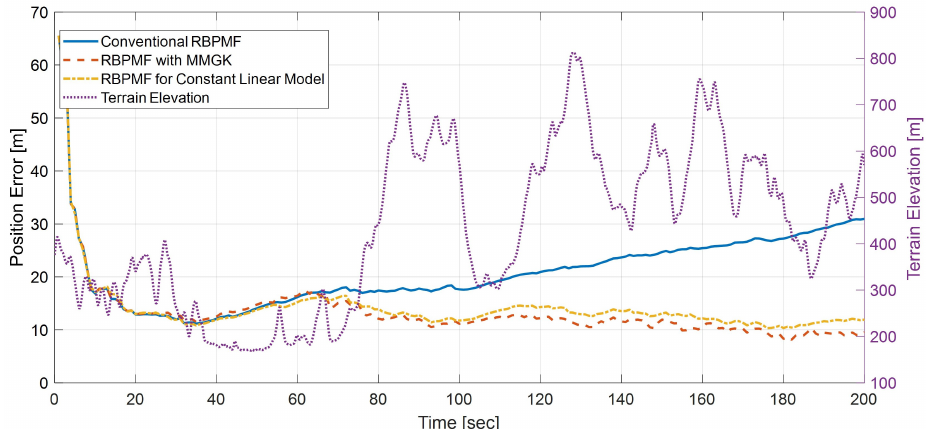
Figure 12. Comparison of the position error RMS of the conventional RBPMF (Algorithm 3), RBPMF with MMGK (Algorithm 4), and RBPMF for constant linear model (Algorithm 5).